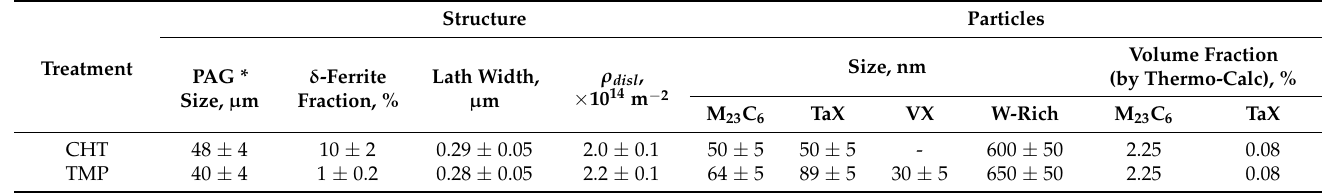
Table 7. Structural parameters of the 12CrTaNb0.003N steel exposed of the CHT and TMP. Structure Treatment